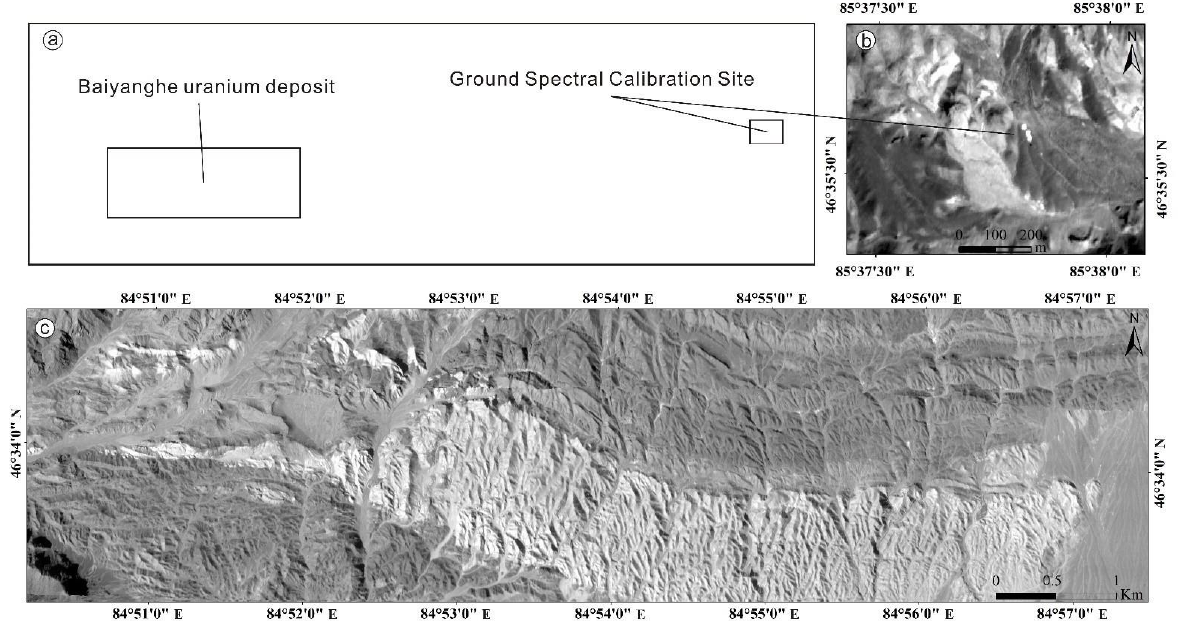
Figure 2. ( a ) Diagram of the test area and ground spectral calibration site, ( b ) SASI image (band 5) of the ground spectral calibration site, and ( c ) SASI image (band 5) of the test area, consisting of two adjacent airborne images.